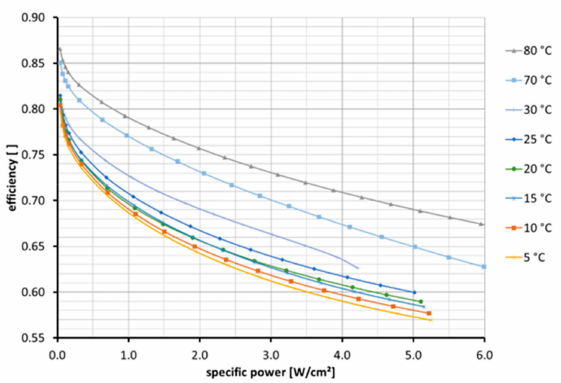
Figure 7. Electrolyzer e ffi ciency across a specific power range at di ff erent temperatures. NR212 with reduced catalyst loading—anode: 0.38 mg / cm 2 IrO 2 | cathode: 0.13 mg / cm 2 Pt.